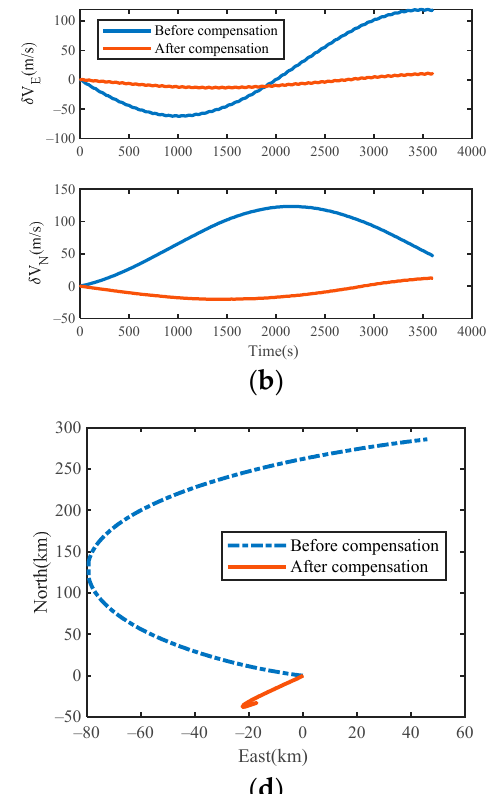
Figure 14. ( a ) Experimental results of attitude errors; ( b ) experimental results of velocity errors; ( c ) experimental results of position errors; ( d ) compare the trajectory of the carrier.